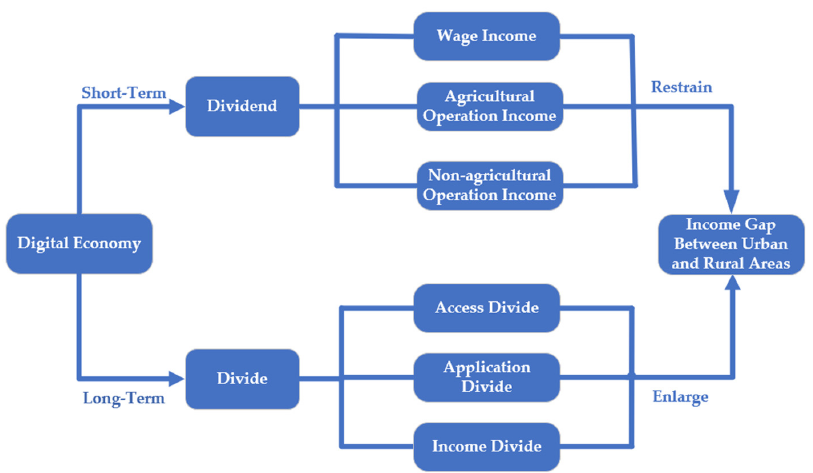
Figure 2. The path of the impact of the digital economy on the income gap between urban and rural rural areas.